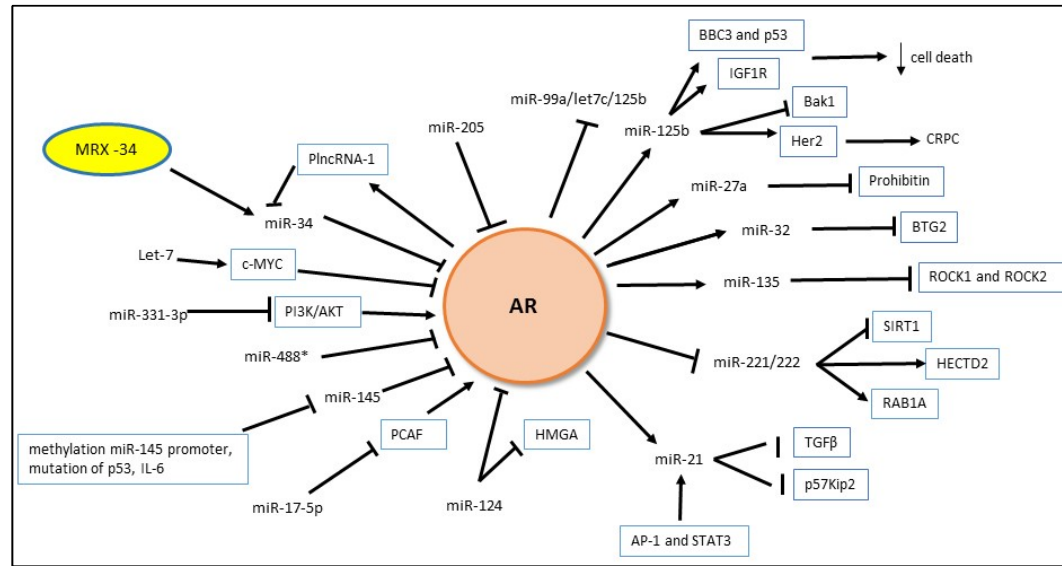
Figure 3. Mutual regulatory model of miRNAs and androgen receptor (AR). The graphic also shows MRX-34, the first miRNA based therapy for cancer. BBC3: Bcl-2-binding component 3; IGF1R: Insulin-like growth factor 1; Bak1: Bcl-2 homologous antagonist/killer 1; HER2: human